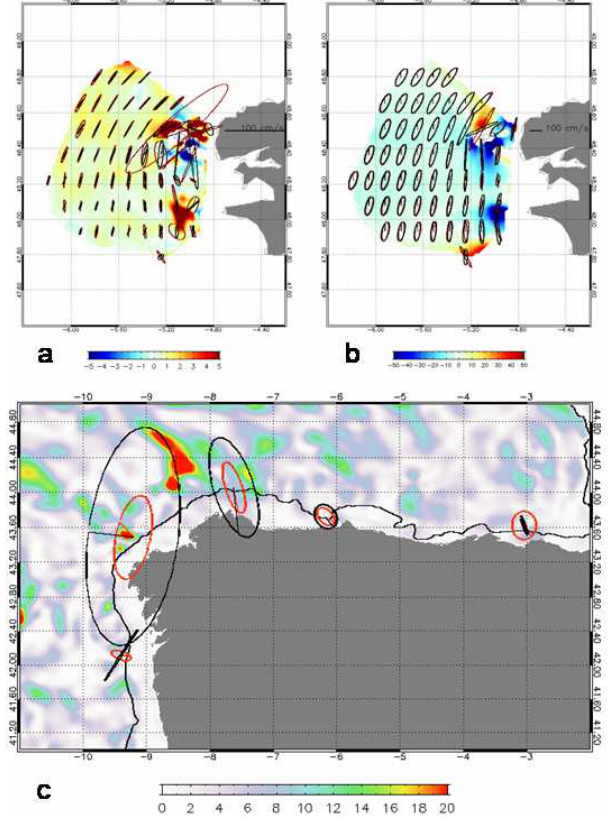
Figure 9: a) and b): M2 (a) and M4 (b) modeled (black) and observed (red) surface tidal ellipses at HF radar measurements locations. Shaded contours represent the difference model-observation semi-major axis (cm s -1 ). c) Modeled (black) and observed (red) near surface M2 tidal ellipses at Puertos del Estado current meters locations. Shaded contours: M2 surface velocity difference between the run with stratification (runbc) and the run without stratification (runbt). On each figure, the black line indicates the 200m bathymetry isoline.